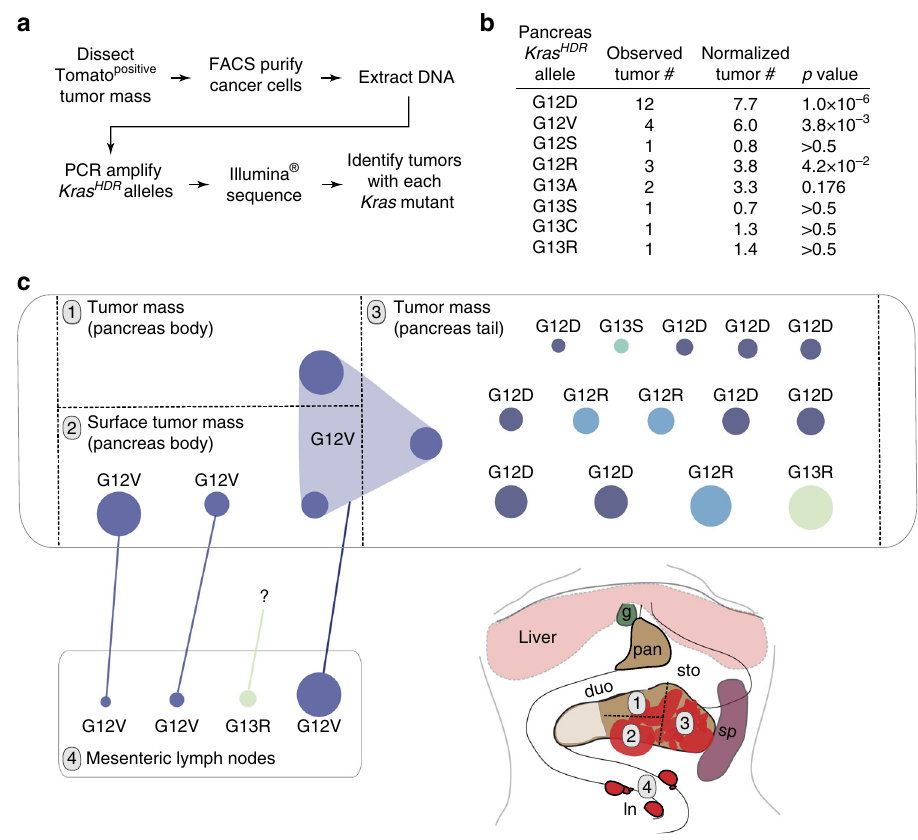
Fig. 7 High-throughput sequencing of pancreatic tumor masses enables spatial mapping of tumor clones and phylogenetic tracking of metastases. a Analysis pipeline to identify Kras HDR alleles in AAV- Kras HDR /sg Kras / Cre -initiated tumor masses within the pancreata of PT;H11 LSL-Cas9 mice. b Diverse HDR-generated Kras alleles identi fi ed by tumor barcode sequencing of pancreatic tumor masses from three PT;H11 LSL-Cas9 mice. Numbers of uniquely barcoded primary tumors with each allele (including those identi fi ed by individual tumor analyses, as shown in Fig. 4e) are indicated. Alleles not identi fi ed in any pancreas tumor masses are not shown. For the Kras HDR alleles identi fi ed, Bonferroni-corrected p values for likelihood of enrichment relative to WT are shown (Fisher ’ s exact test generalized for structural zeros; see Methods section) ( p values < 0.05 are bold). c Multi-region sequencing of a large pancreatic tumor mass in a PT;H11 LSL-Cas9 mouse transduced with AAV- Kras HDR /sg Kras / Cre revealed a diverse spectrum of mutant Kras alleles and uncovered relationships between primary tumors and their metastatic descendants. Each dot represents a tumor with the indicated Kras variant and a unique barcode within each sample (labeled 1 – 4). Dots connected across different primary tumor samples (labeled 1 – 3) shared the same Kras variant- barcode pair, and are thus presumably regions of the same primary tumor that were present in multiple samples. A colored line links primary tumors and lymph node metastases harboring the same Kras variant-barcode pair, indicating a clonal relationship. The size of each dot is scaled according to the size of the tumor that it represents (diameter of the dot = relative size 1/2 ). Since the size of pancreatic tumors was not normalized to a control, tumor sizes can only be compared to other tumors within the same sample. Thus, the largest tumors within each sample have been scaled to the same standard